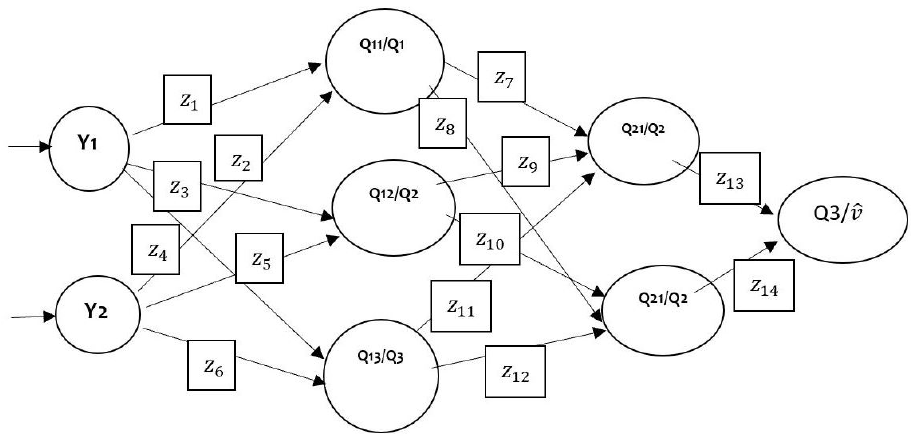
Figure 1. A Normal representation of feed-forward